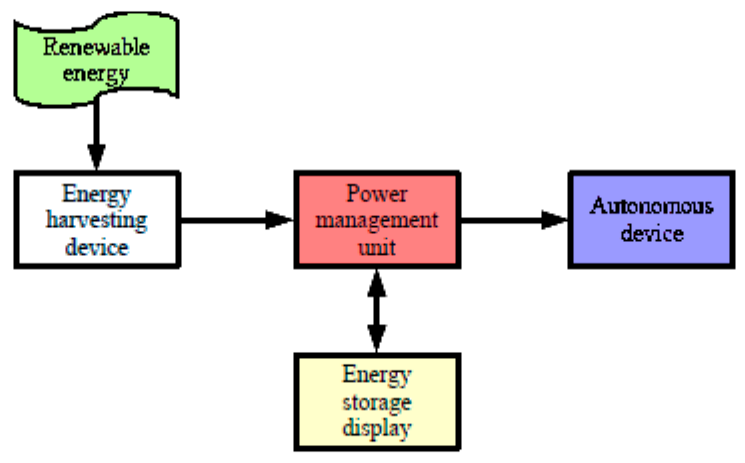
Figure 1. Autonomous system supply principle.